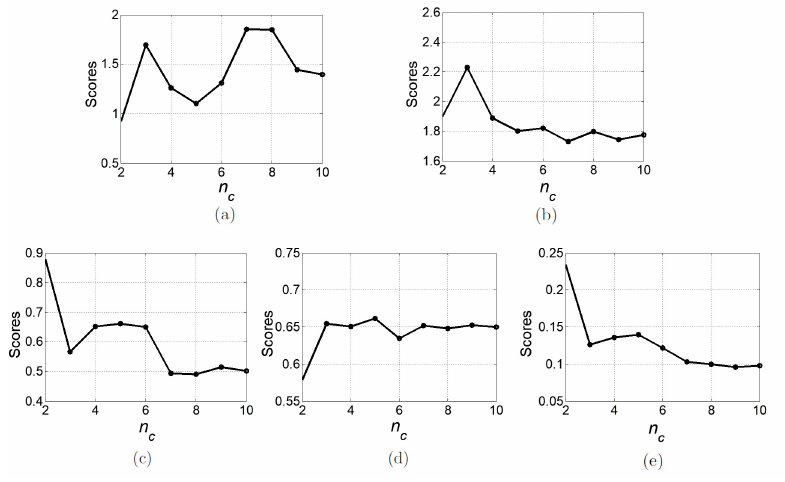
Figure 14. Evolution of CVIs for winter using the KM algorithm for n c clusters indicated by: ( a ) XB ( ↓ ); ( b ) DB ( ↓ ); ( c ) DI ( ↑ ); ( d ) WI ( ↑ ); ( e ) Sil ( ↑